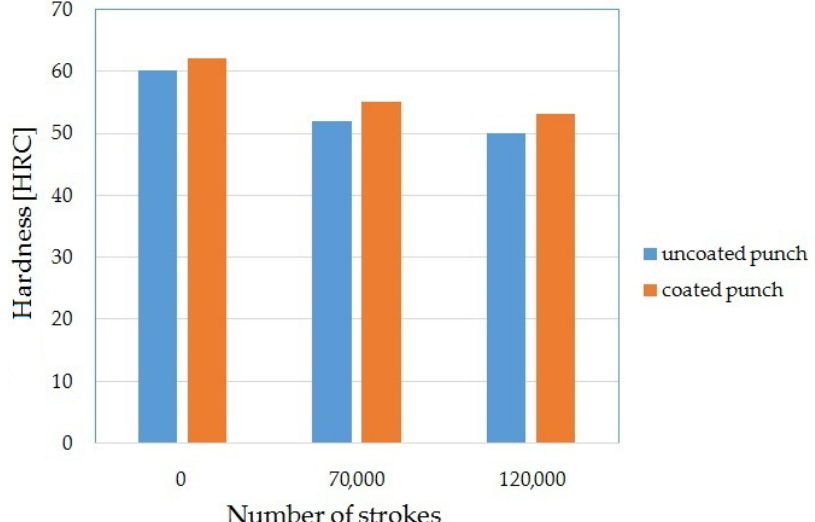
Figure 6. Hardness test results.